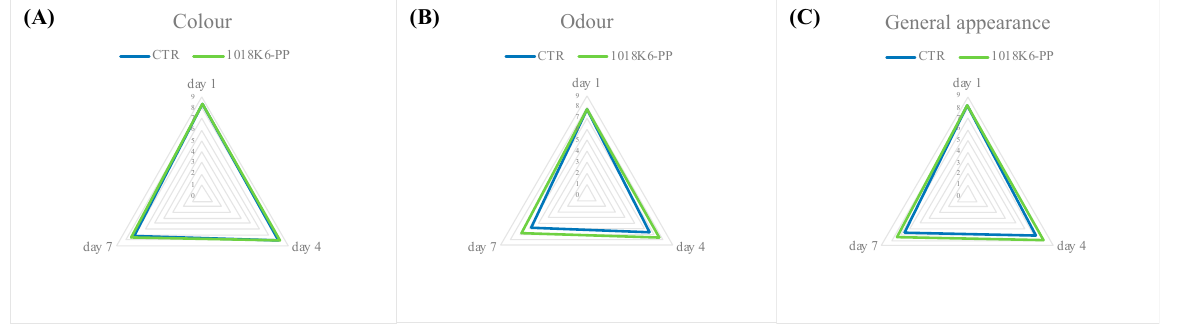
Figure 4. Changes in colour ( A ), odour ( B ), and overall appearance ( C ) of salmon fillets during storage period. CTR (blue lines)—PP films without 1018K6; 1018K6-PP (green lines)—PP films functionalized with 1018K6.